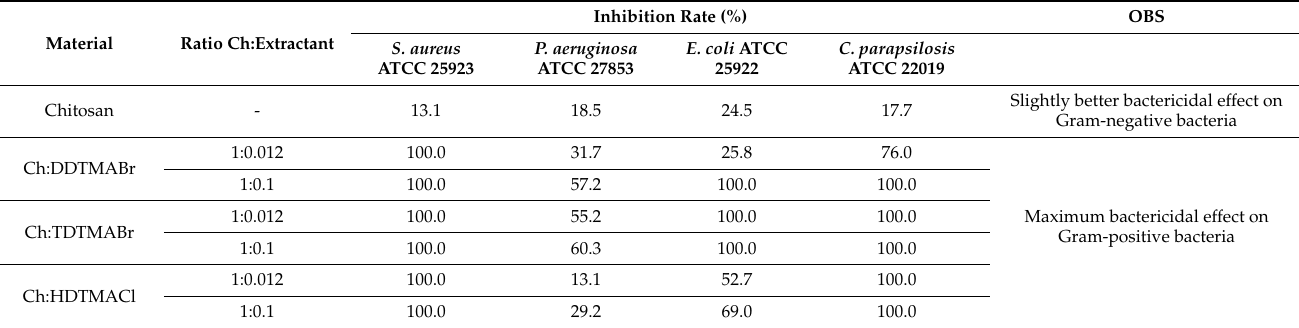
Table 2. Inhibition rate of bacterial and fungal growth when using nitrogen heteroatom materials. Material